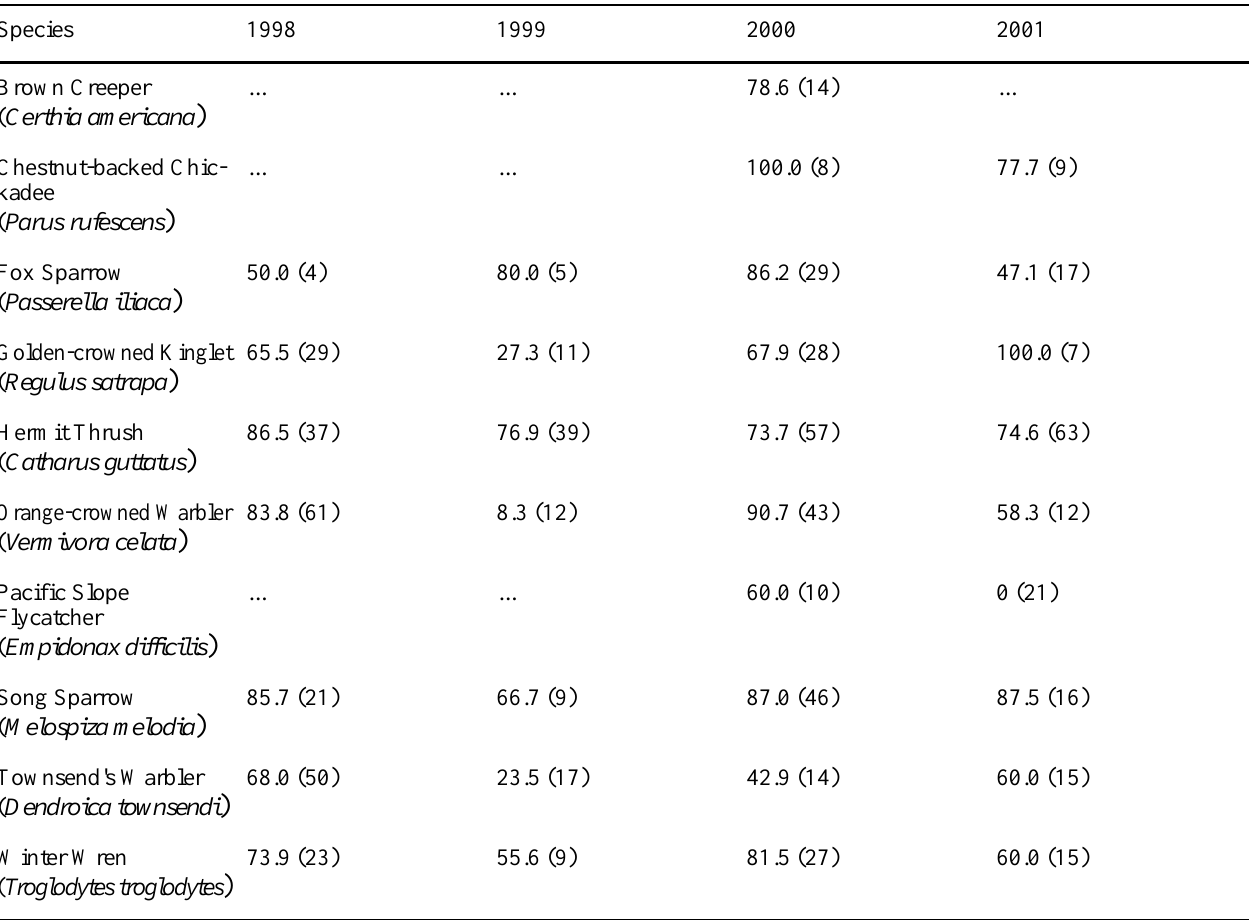
Table 4 . Maximum % of hatching-year birds captured in any 10-d period during core mist-netting. Sample sizes are given in